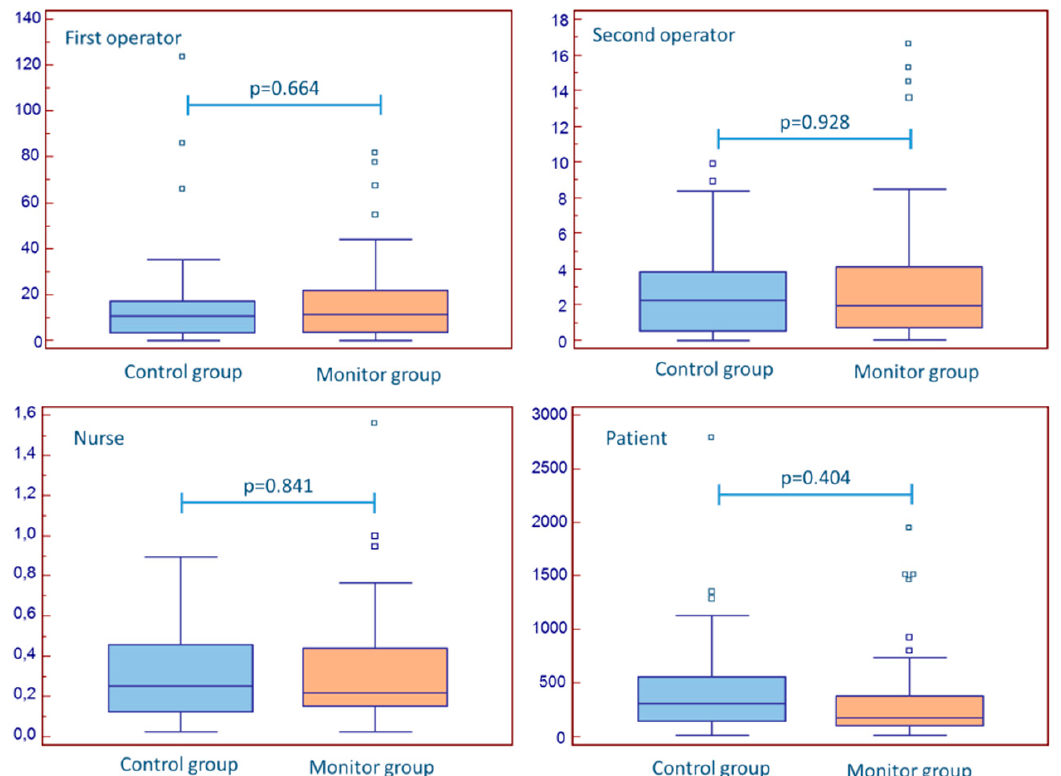
Figure 4. The impact of real-time monitoring in procedures in patients with BMI > 30. Table 3. Exposure in procedures lasting >60 min. Group Control